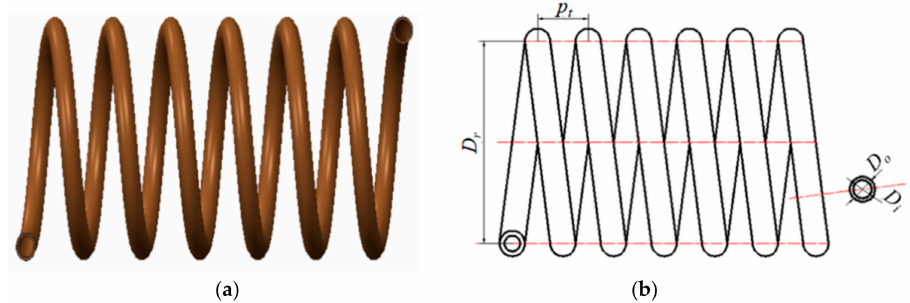
Figure 3. Structure of the spiral cooling pipe. ( a ) 3D schematic; ( b ) Dimension